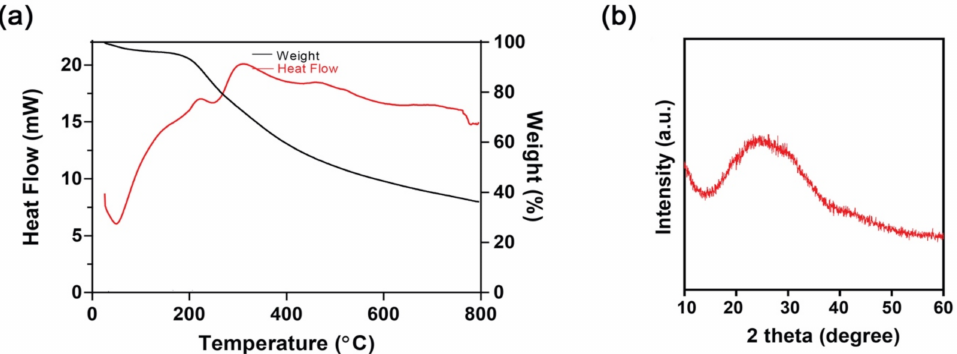
Figure 2. Characterization of PTh–NPs of ( a ) Thermogravimetric curve (wt. % vs. temperature curve) and di ff erential scanning curve (heat flow vs. temperature curve, and ( b ) X-ray di ff raction.